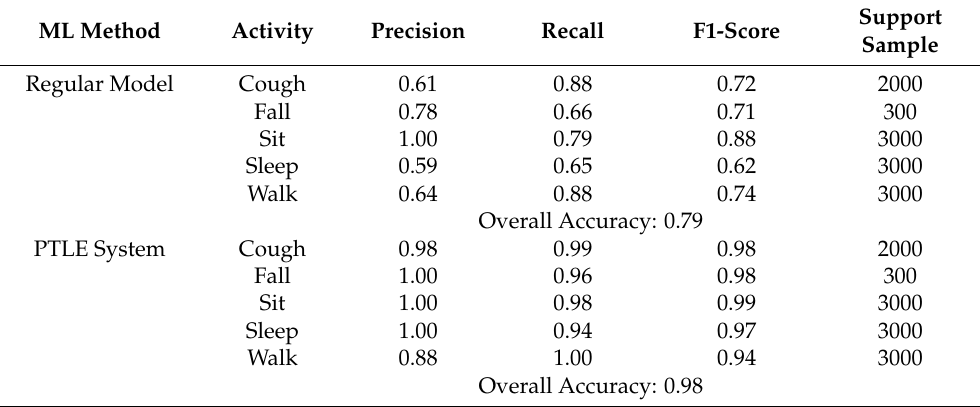
Table 4. Regular model and PTLE